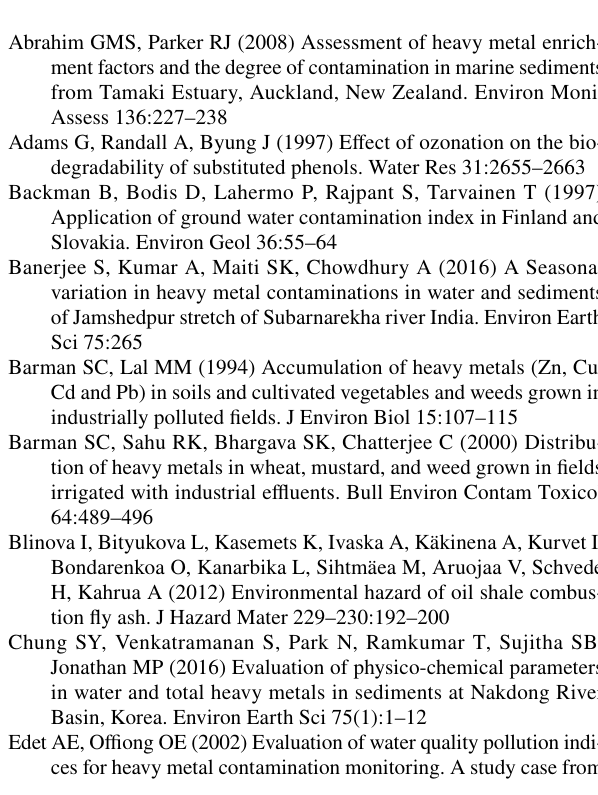
Values in bold correspond to each variable to the factor for which the squared cosine is